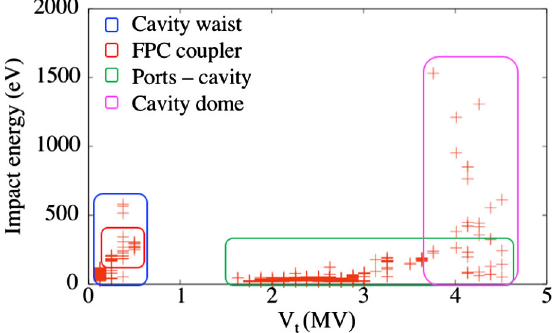
FIG. 5. Impact energy of multipacting electrons found by ACE 3 P Track3P simulations at different deflecting voltage levels.